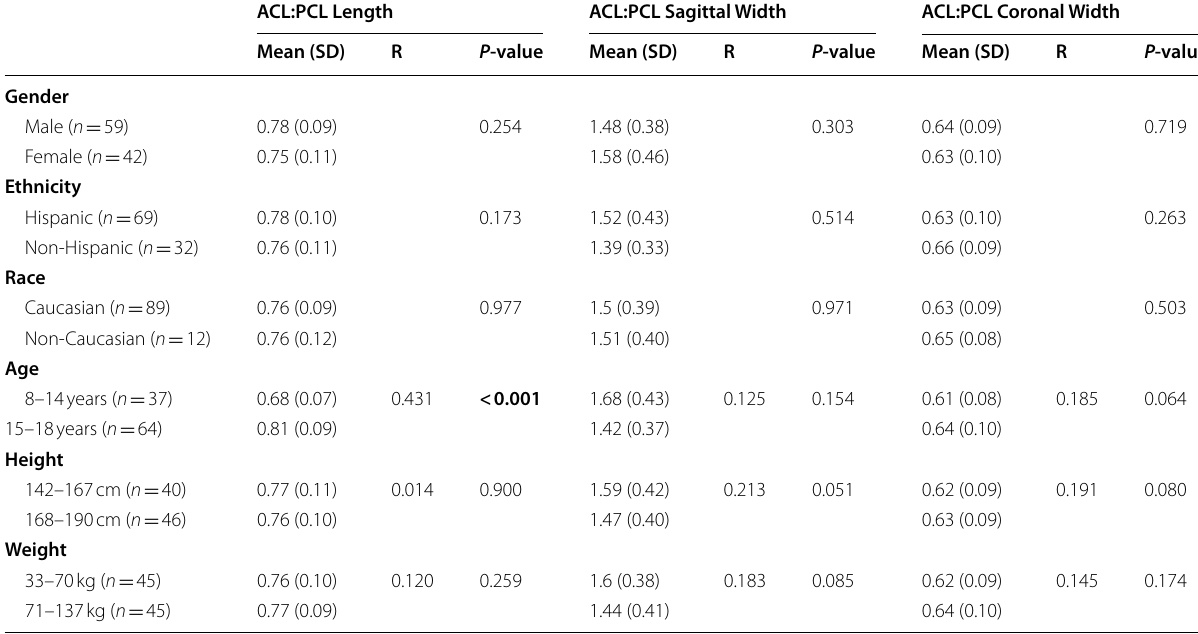
Table 3 ACL:PCL Ratios and Demographic Comparison